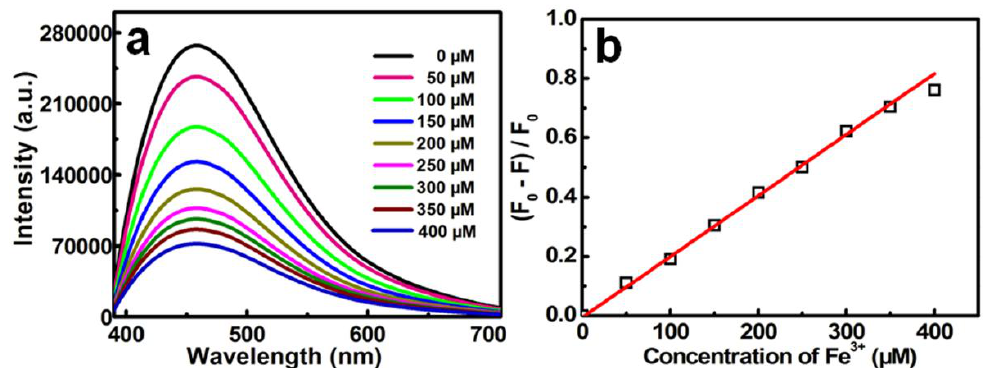
Figure 8. ( a ) PL spectra for the CQDs-120 with various Fe 3+ concentrations as indicated; and ( b ) the linear relationship of ( F 0 − F )/ F 0 versus the Fe 3+ concentration.